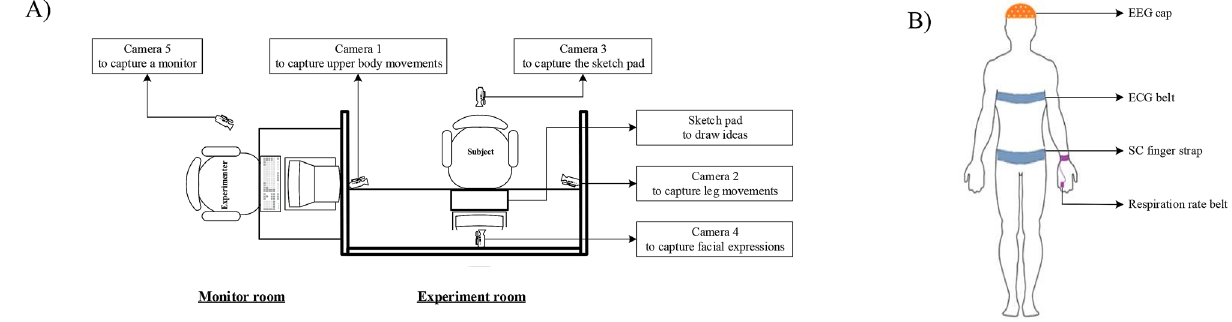
Figure 8. ( A ) View of the experimental configuration adapted from Nguyen and Zeng 28 with copyright permission from Elsevier. ( B ) Configuration of the